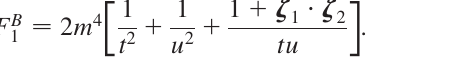
FIG. 1. Ratio of the function f ð (cid:9); (cid:10) Þ to its limit value f ð (cid:9); 0 Þ ¼ ln1 =(cid:9)